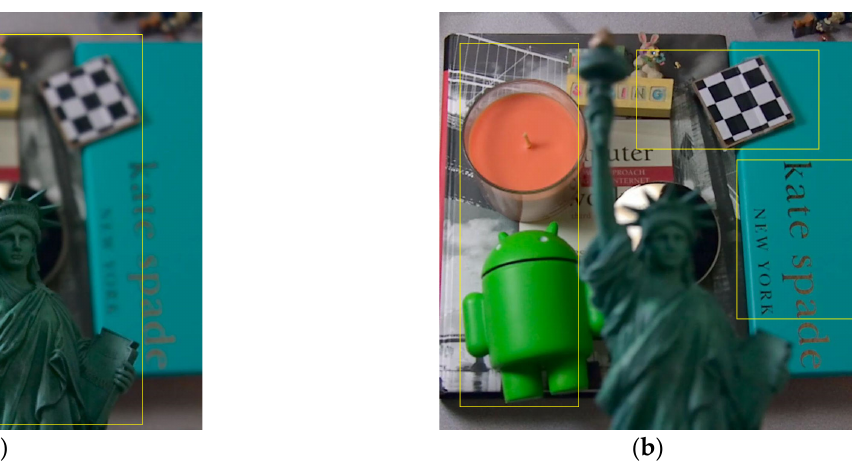
Figure 1. Two of the focus ‐ stacked images: ( a ) Focus on the foreground; ( b ) Focus on the background.